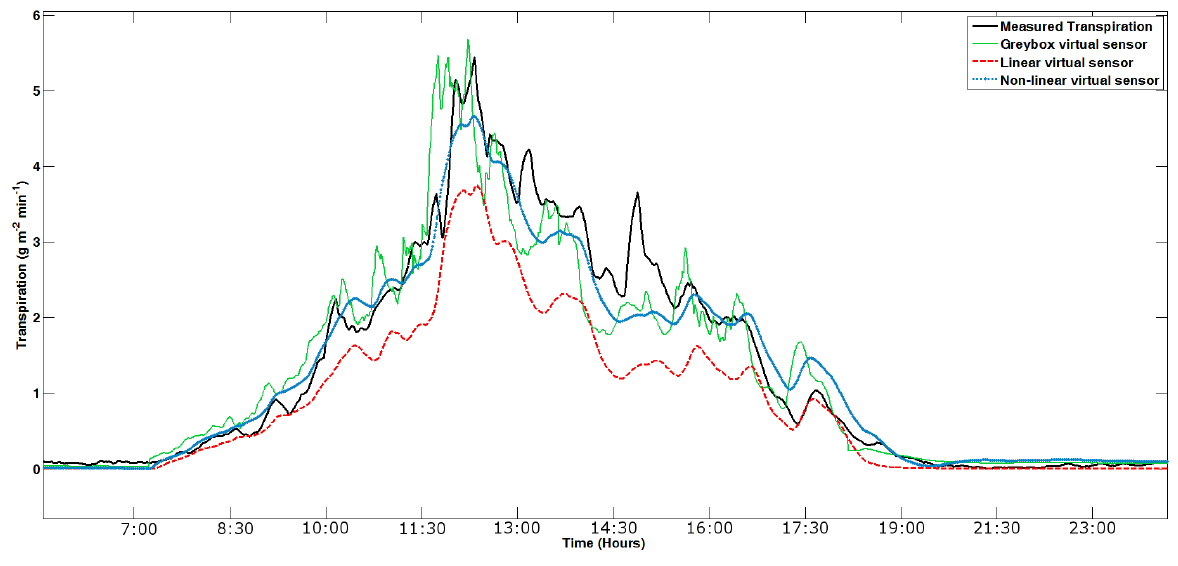
Figure 11. One full day in 2008